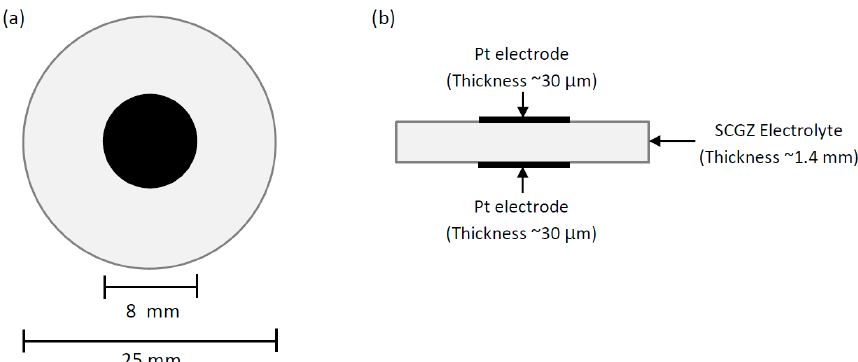
Figure 1 . Schematic drawing of electrolyte - supported solid oxide electrolysis cells ( SOEC ) ; ( a ) top Figure 1. Schematic drawing of electrolyte-supported solid oxide electrolysis cells (SOEC); ( a ) top view, view, ( b ) side view . ( b ) side